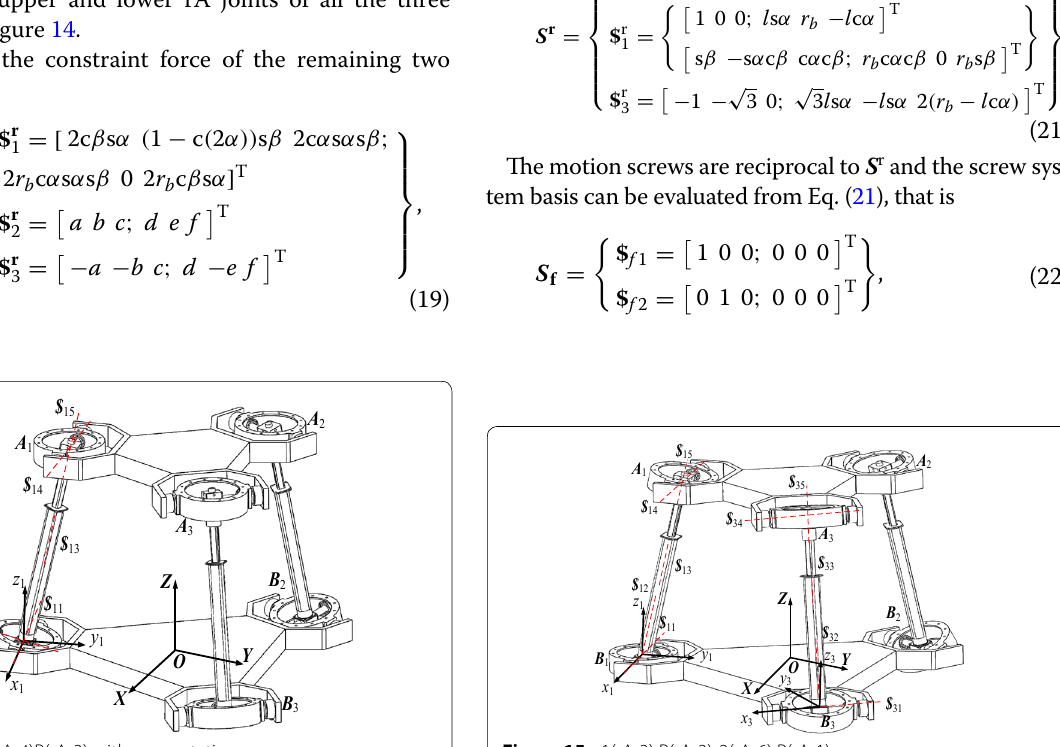
Figure 14. 3(rA-4)P(rA-3) with pure rotation Figure 15. 1(rA-3) P(rA-3)-2(rA-6)